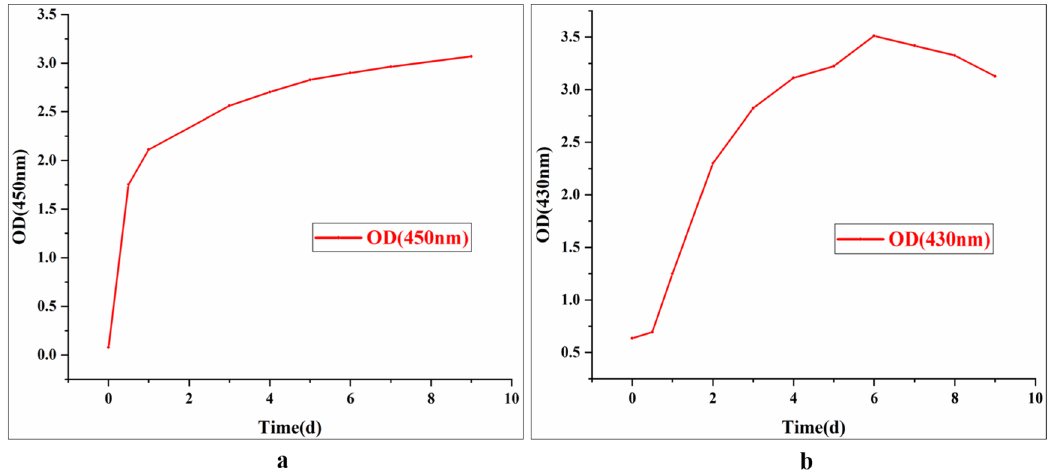
Figure 5. Absorption spectra of solutions with different pH (from 1.0 to 8.0) ; this reaction happens in a conical flask wrapped with tinfoil at 28 °C for 4 d [( a ) solutions are treated with HX-YS; ( b ) solutions are treated with LPP-12].